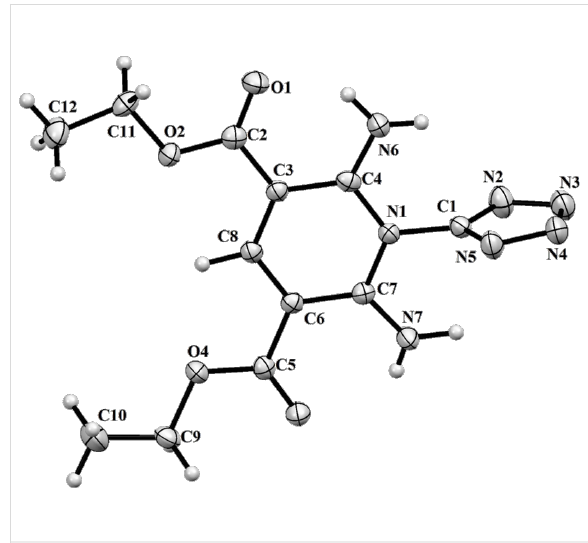
Figure 2: X-ray crystal structure of compound 11 (ORTEP drawing, 50% probability level).